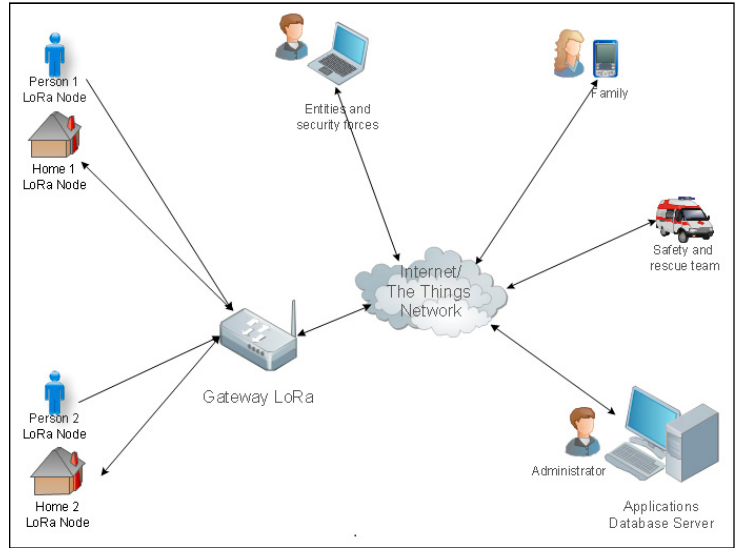
Figure 4. Conceptual scheme of the system .